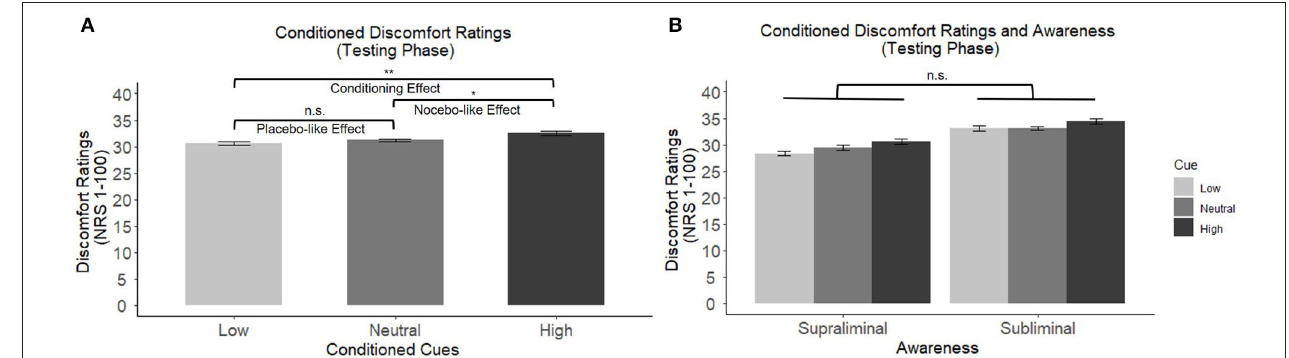
FIGURE 1 | (A) Main effects of conditioned cues on discomfort ratings of moderate temperatures. Post-hoc comparisons revealed a significant conditioning effect and a significant nocebo-like effect. (B) No significant difference between cues presented supra- vs. subliminally (between subject factor “awareness”). * p < 0.05,